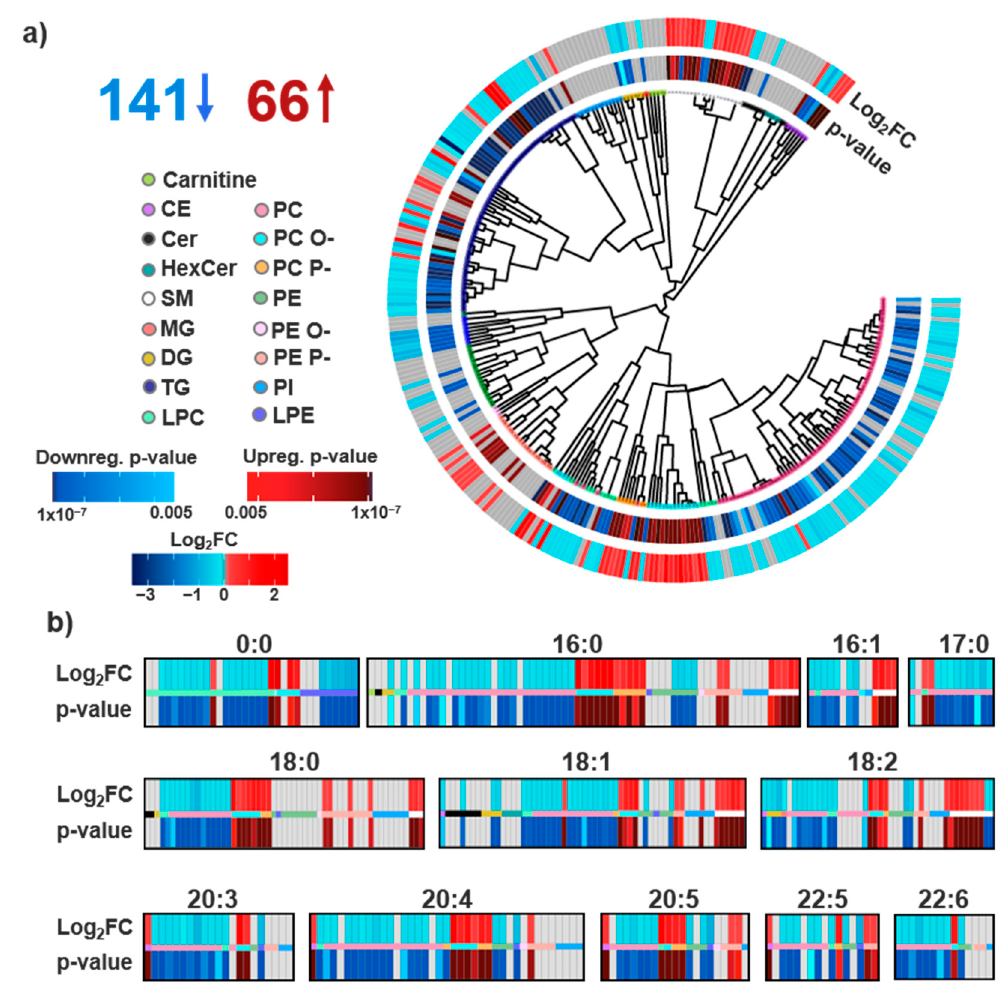
Figure 3. Lipids detected and statistically significant in the PMI comparison. ( a ) Of the 299 uniquely identified lipids, 141 were statistically downregulated and 66 were upregulated following a PMI with a p -value cut-off of 0.005. The lipid head group associations are visualized in a circular dendrogram with p -values (inner ring) and Log2FC (outer ring) statistics overlaid simultaneously for each lipid identification. ( b ) FA lipid composition was also investigated by plotting all unique FA components. Statistically significant lipids are shown in red and blue for up- and downregulation, and identified lipids lacking statistical significance are shown in grey. The magnitude of variation for Log 2 FC and adjusted p -values are visualized through a color gradient, with darker colors indicating a more significant p -value or larger fold change.